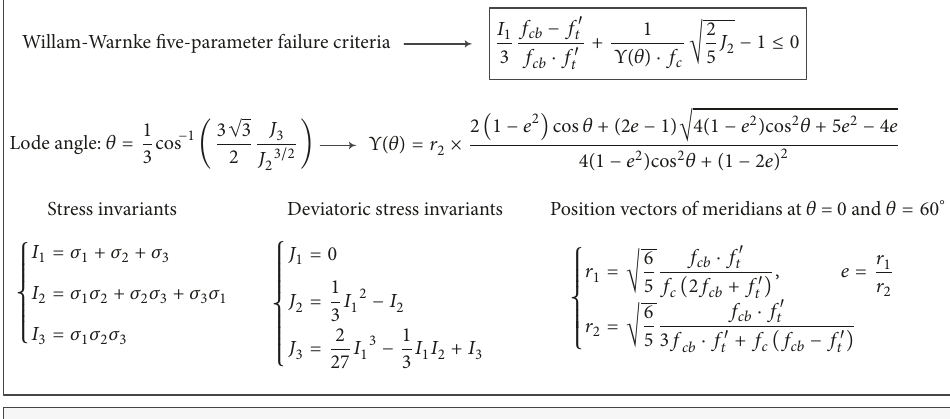
Willam-Warnke five-parameter failure criteria